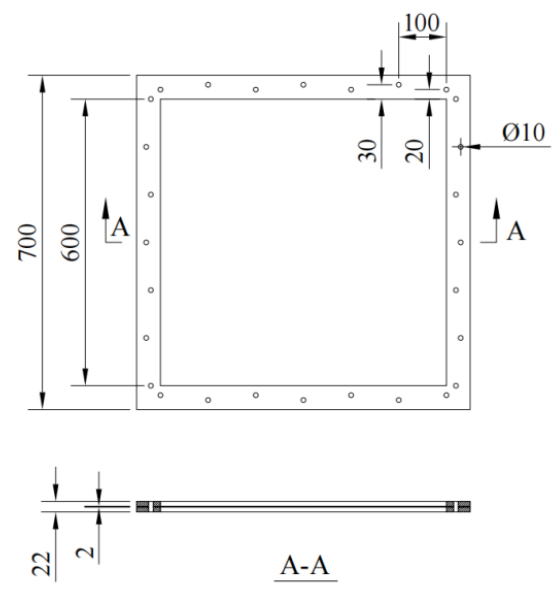
Table 1. Summary of test parameters.